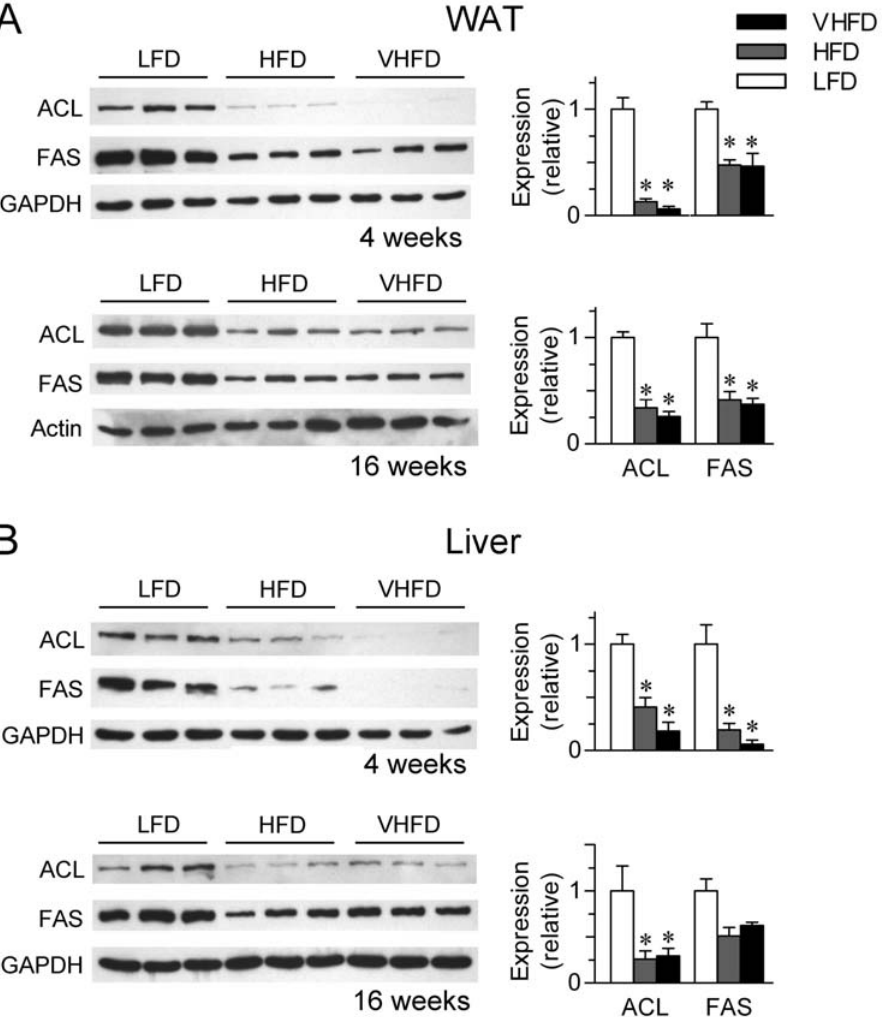
Figure 3. High-fat diet feeding suppresses the expression of lipogenic enzymes both in the white adipose tissue and liver. Western immunoblot analysis of the expression of ACL and FAS in the (A) WAT or (B) liver from mice fed LFD, HFD and VHFD for 4 and 16 weeks, respectively. Each lane represents the tissue extract from one animal. Bar graphs indicate the relative protein expression levels determined by densitometric quantification of the immunoblots after normalization to actin or GAPDH. Data are shown as mean 6 SEM (n=3/group). *p , 0.05 vs. LFD-fed